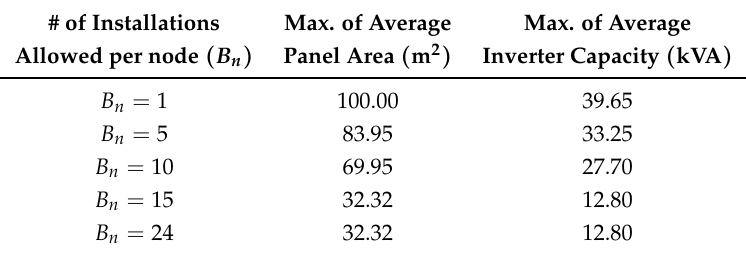
Table 6. Maximum average panel area and average inverter capacity.